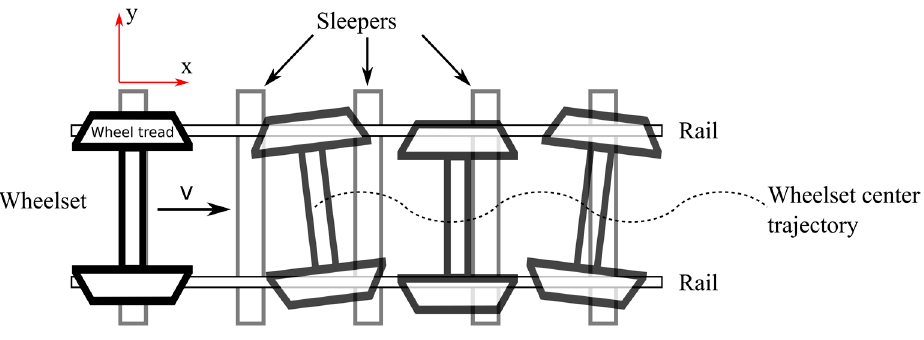
Figure 1. Wheelset hunting.